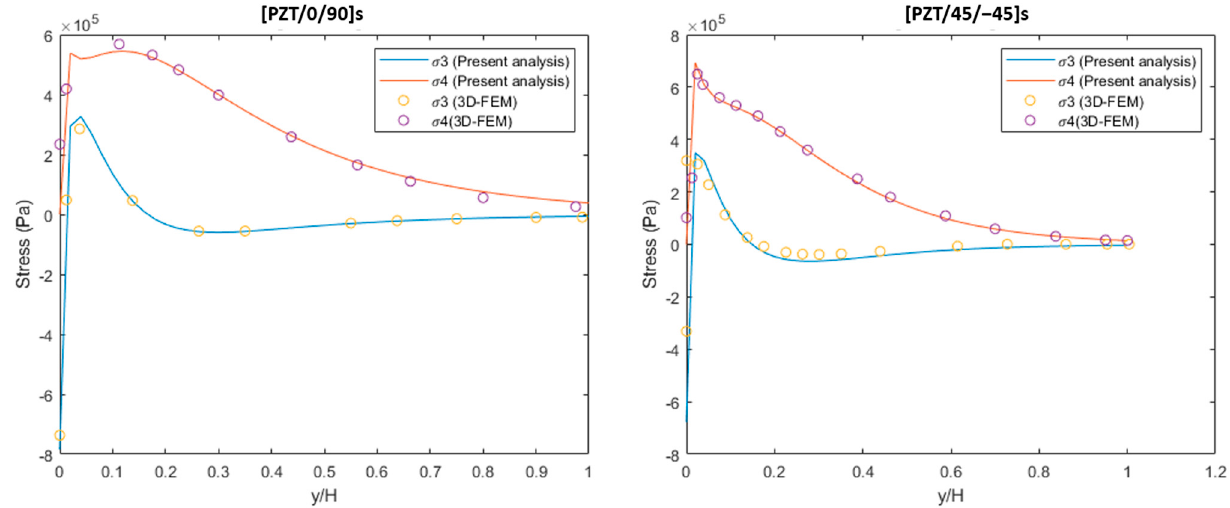
Figure 8. σ 3 and σ 4 at the PZT/0 and PZT/45 interface of cross-ply and angle-ply laminates under the electrical excitation.